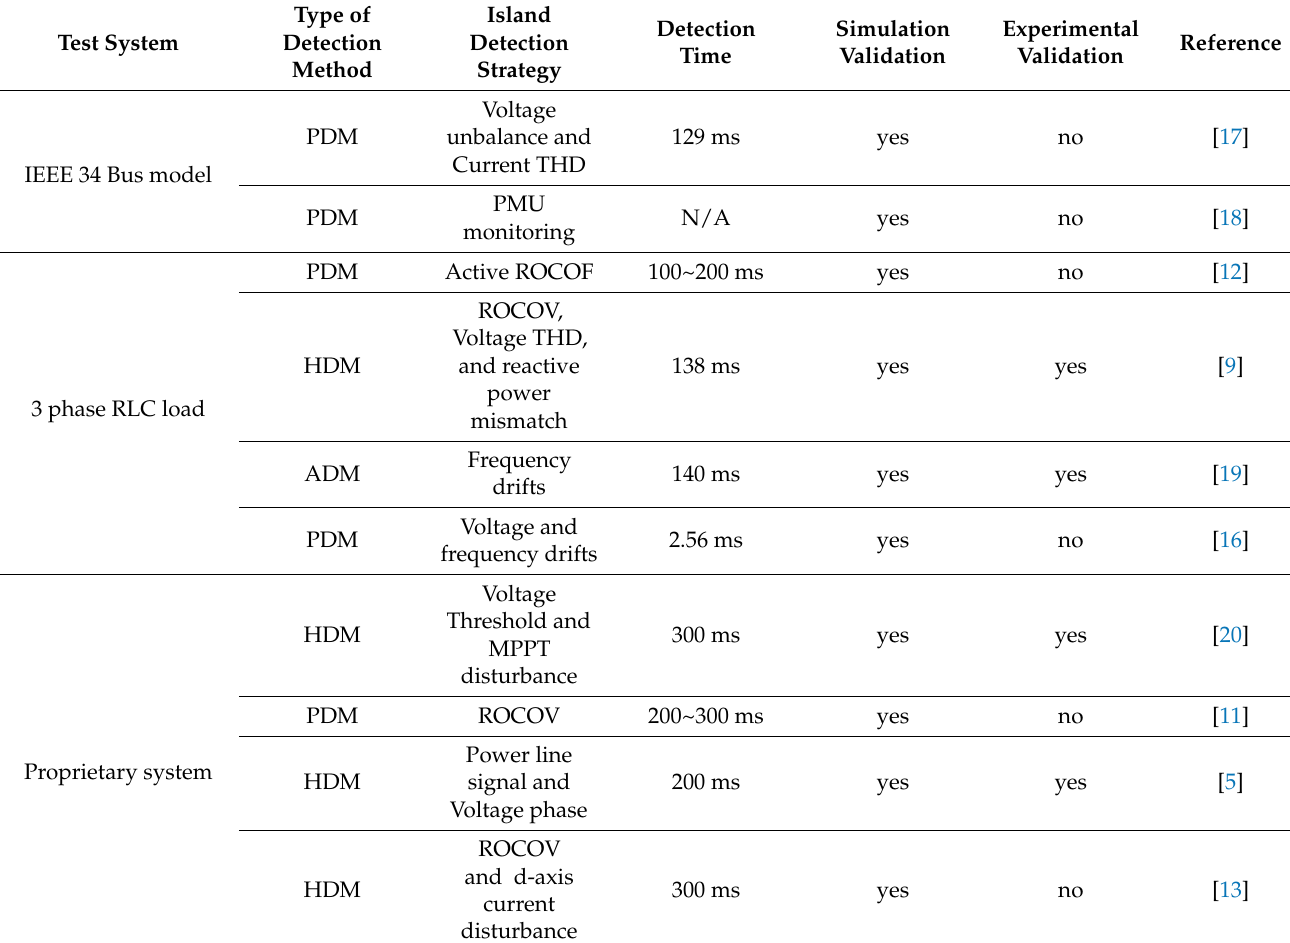
Table 1. State of the art review of islanding detection